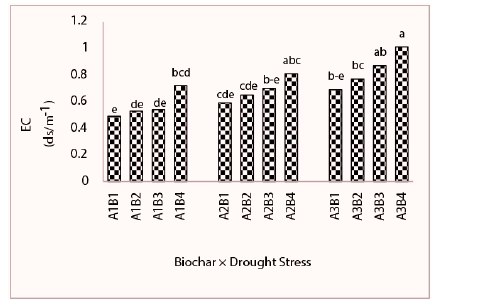
Figure 7 The effects of the interaction of drought stress and biocharon soil EC. Mean values with the same letters are not significantly different at p ≤ 0.05 according to LSD